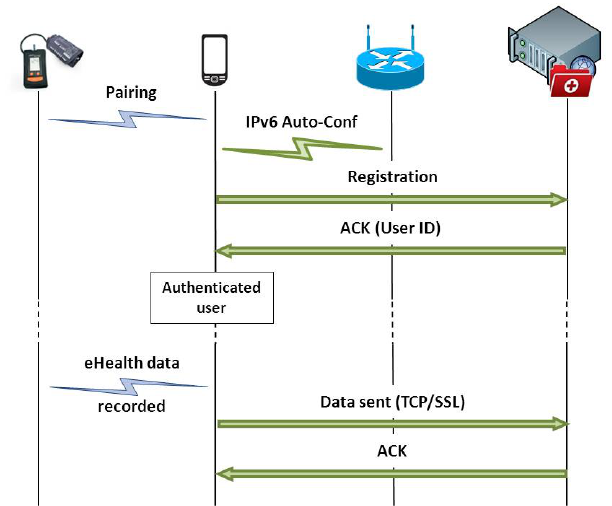
Figure 5. End to end message exchange diagram. Once the eHealth device is paired to the cluster head (and recognized by the application), the cluster head can be attached to the mobile router and obtain his configuration. The validity of this configuration is assured by the mobile router lightweight configuration protocol presented in Section 5. The cluster head registers at the electronic health record (EHR) and transmit eHealth-related data over